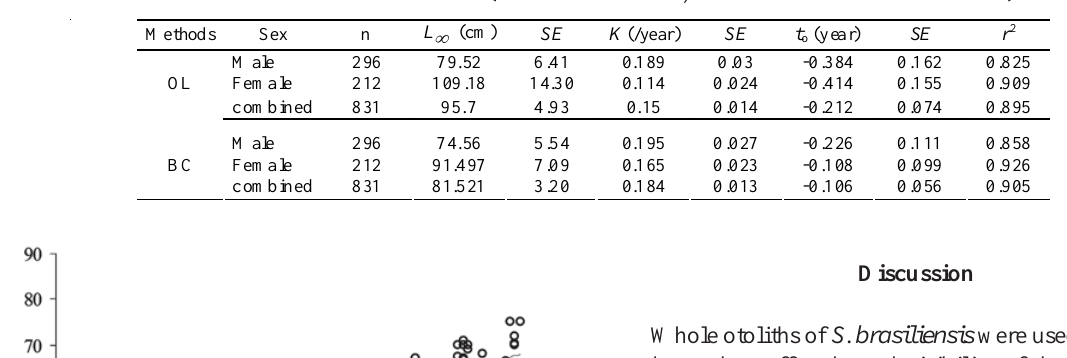
Table 3. Von Bertalanffy growth parameters calculated from observed lengths (OL) and back-calculated (BC) lengths of Spanish mackerel collected off northeastern Brazil ( SE - standard error; r 2 - coefficient of determination).